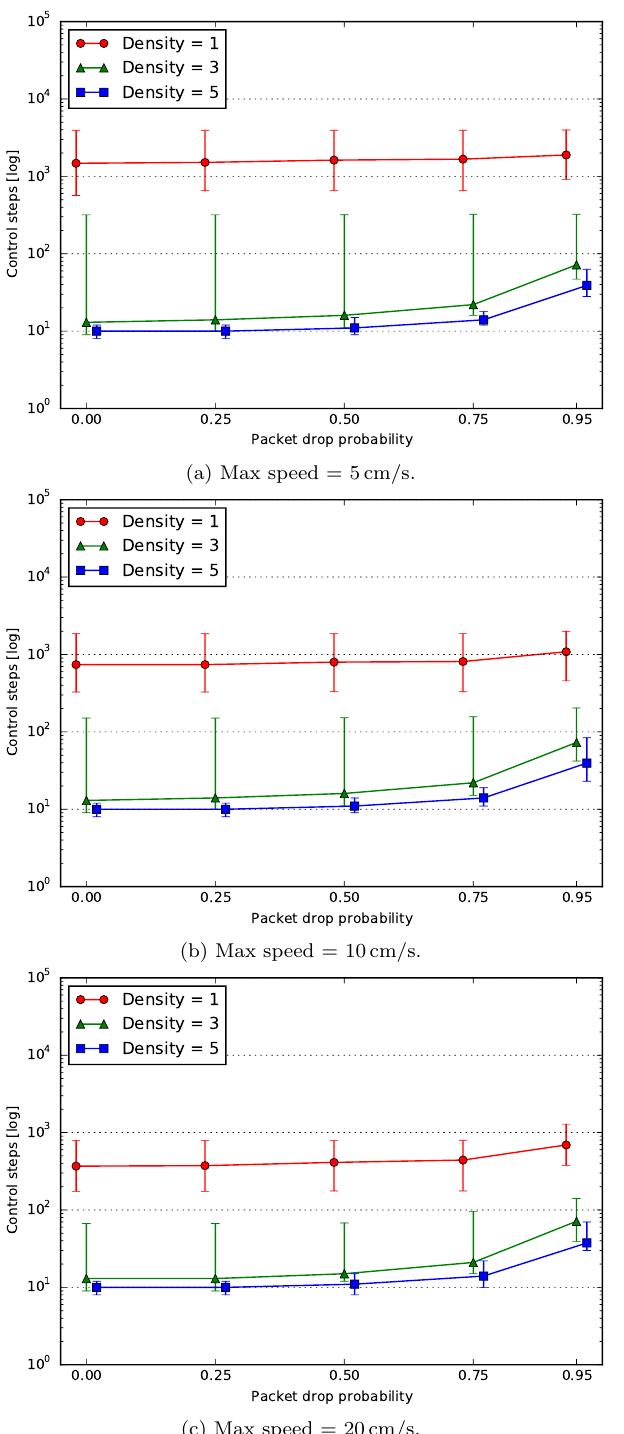
(c) Max speed = 20cm/s. Figure 5: Convergence time (in control steps) for dynamic topologies in different experimental configurations. The plot reports the median, max, and min values of the distributions obtained for each experimental configuration (cid:104) N, P, S (cid:105) over 50 runs. The markers are slightly offset to make them visi-